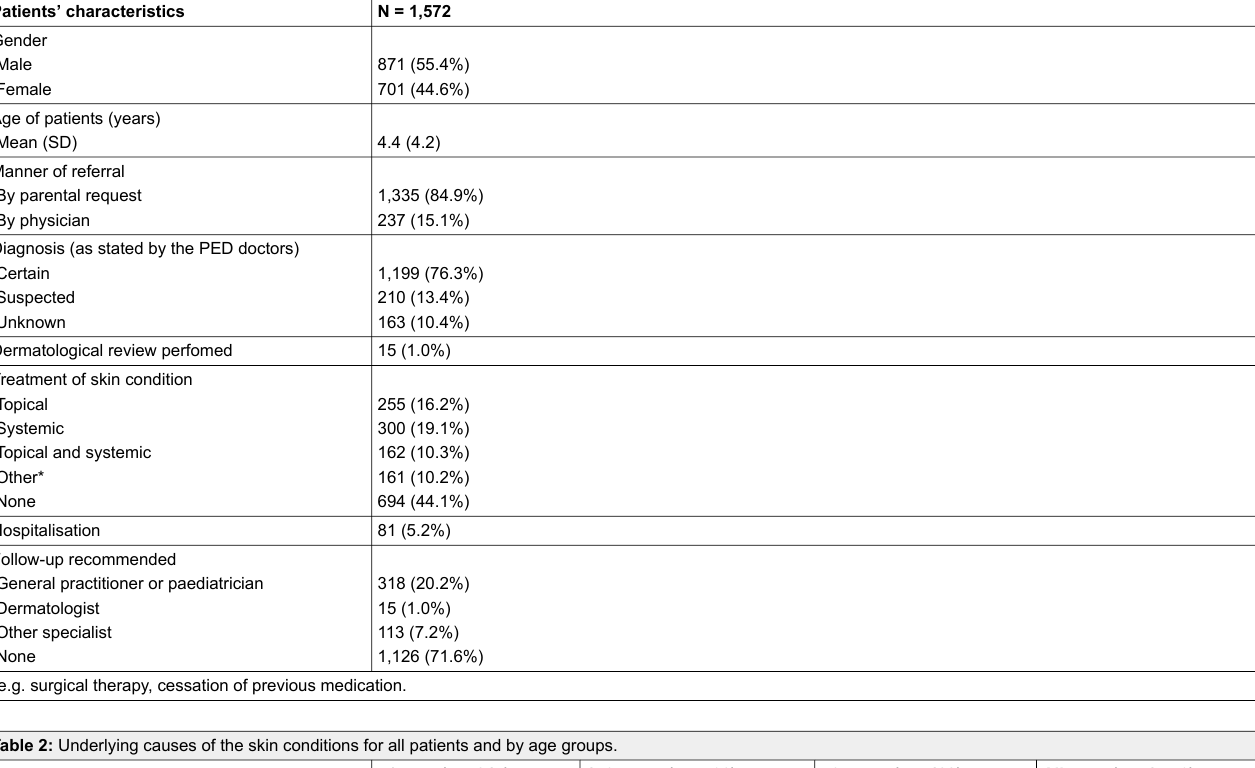
Table 1: Characteristics of the 1,572 attendances at the Paediatric Emergency Department (PED) with dermatological disorders. Patients’ characteristics